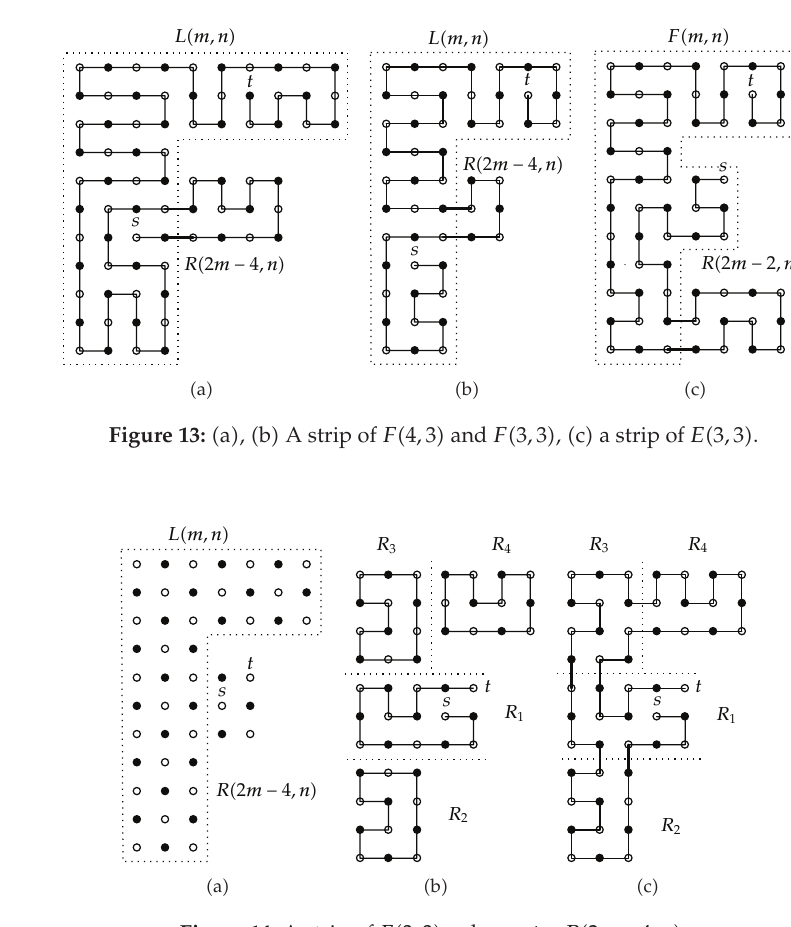
Figure 14: A strip of F (cid:6) 3 , 3 (cid:7) , when s,t ∈ R (cid:6) 2 m − 4 ,n (cid:7)